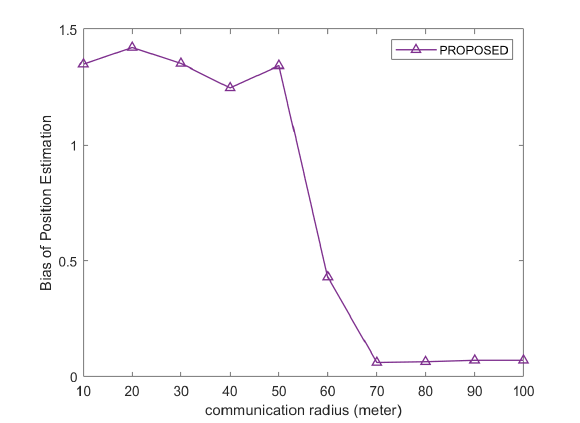
Figure 11. Bias of position estimation versus communication radius.